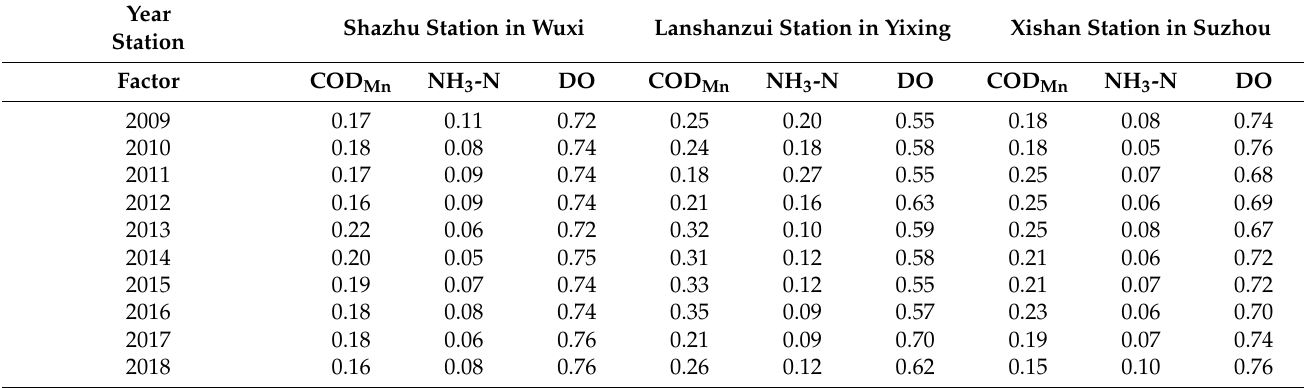
Table A2. Normalized results of water quality evaluation index